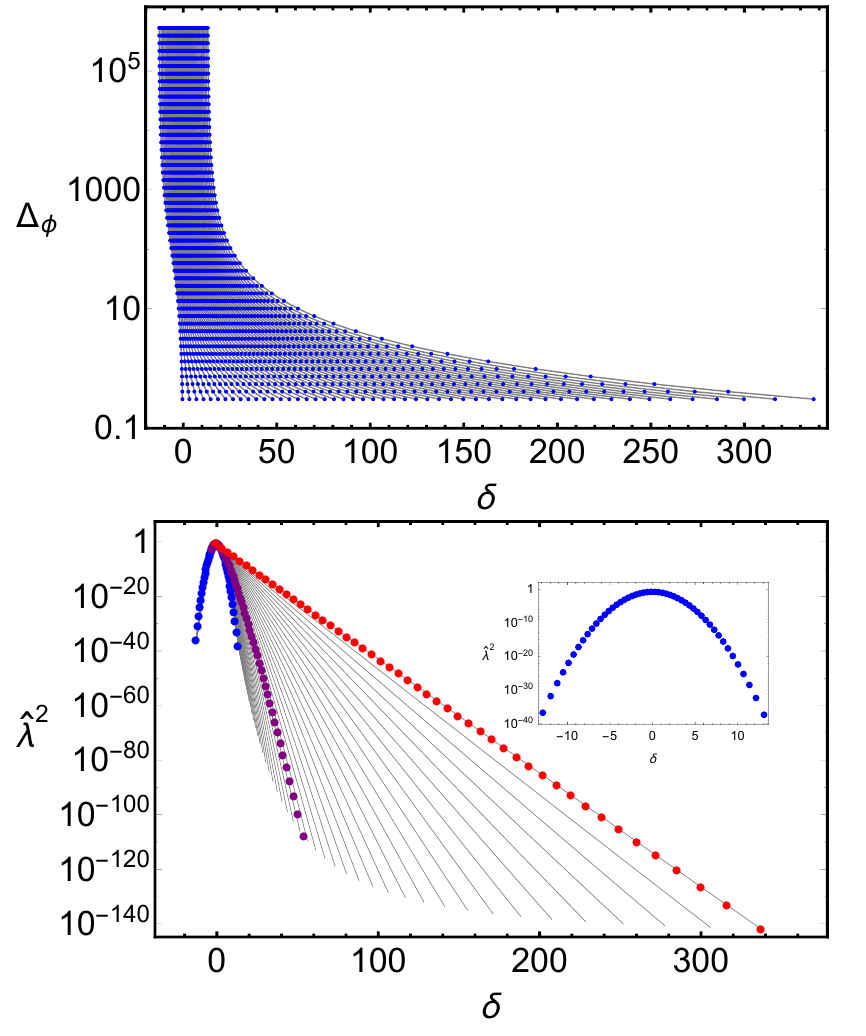
Figure 6 . Gap maximization with 100 components. At the top, the (cid:13)ow of the spectrum of operator dimensions as (cid:1) (cid:30) is increased. Dimensions of operators are shown in terms of (cid:14) (cid:17) ((cid:1) (cid:0) p 2 2(cid:1) (cid:30) ) = p (cid:1) (cid:30) . Each horizontal slice is a spectrum at a given (cid:1) (cid:30) . For large values of (cid:1) (cid:30) the dimensions of operators stabilize in a region with (cid:12)nite width in units of p (cid:1) (cid:30) centered at (cid:14) = 0. On the bottom, the di(cid:11)erent curves show the OPE coe(cid:14)cients for various values of (cid:1) (cid:30) , moving to the left as it is increased. Each curve is actually made up of several points (some of which are shown explicitly) each corresponding to an operator in the spectrum with dimension (cid:14) . The (cid:12)nal con(cid:12)guration, at (cid:1) (cid:30) ’ 6 (cid:2) 10 5 , is highlighted in blue and enlarged in the inset. It is very nearly gaussian with width ’ p (cid:1) (cid:30) . The hats on OPE coe(cid:14)cients means we have written them in \natural units" [6], i.e. ^ (cid:21) 2 ((cid:1)) (cid:17) (cid:21) 2 = (4 (cid:26) ) (cid:1) , with (cid:26) = x j . p x =1 = 2 (1+ 1 (cid:0) x ) 2